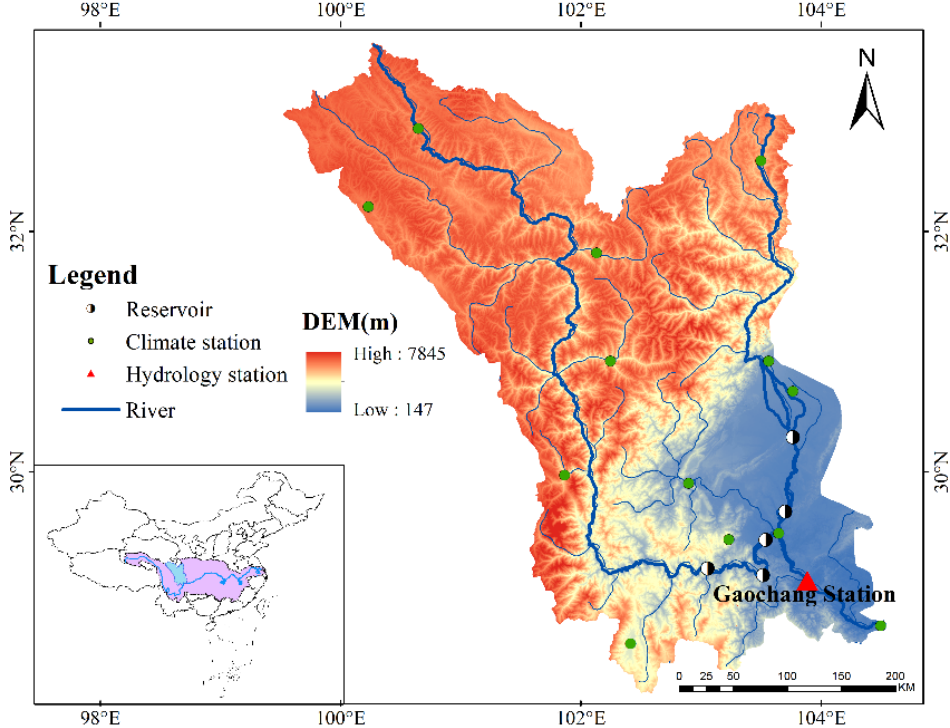
Figure 1. Min River basin map, first-class tributaries of the Yangtze River in China.